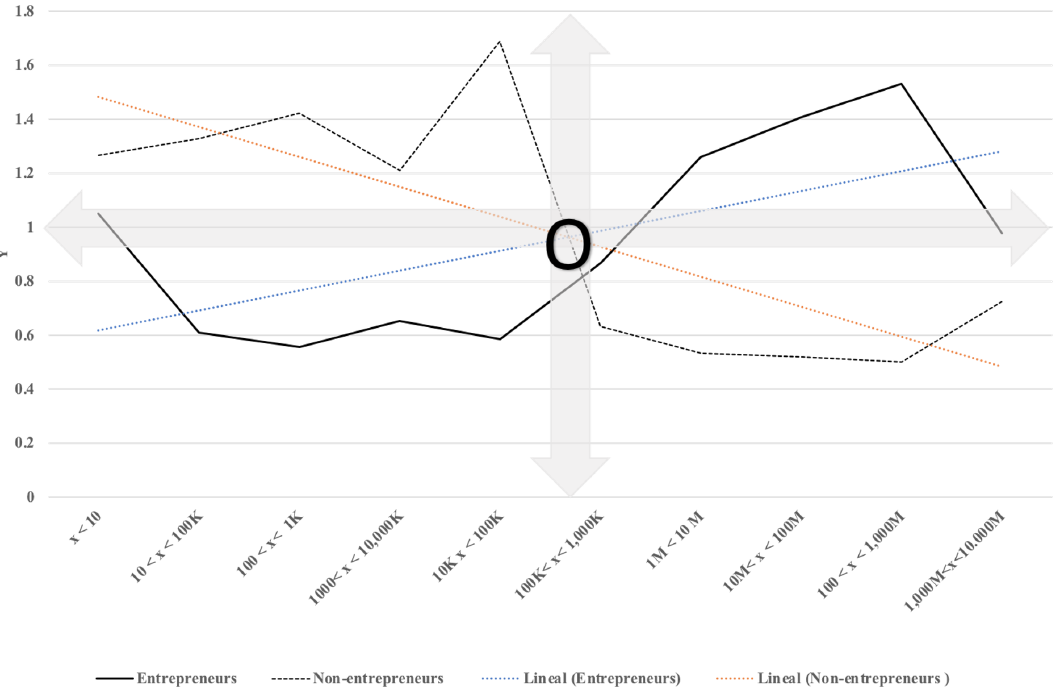
Figure 13. Analysis by